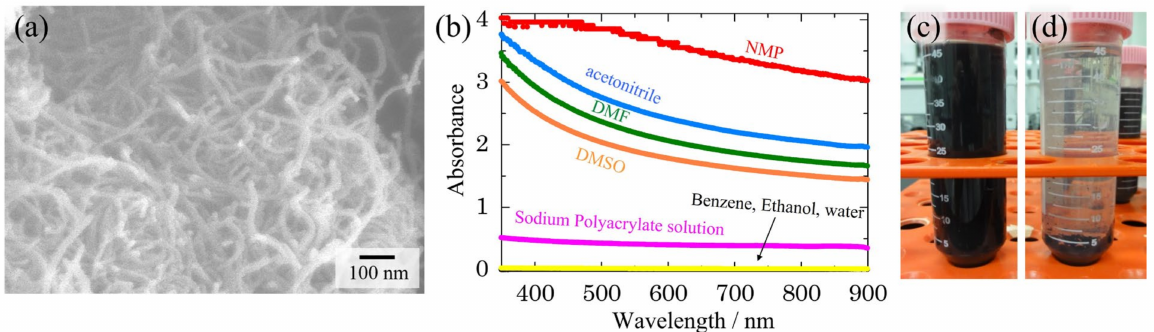
Figure 2. ( a ) SEM image of the used CNTs, ( b ) absorbance of CNT-dispersed solvent, and photographs of centrifuged suspensions: ( c ) NMP with 1 g/L of CNTs, and ( d ) ethanol with 1 g/L of